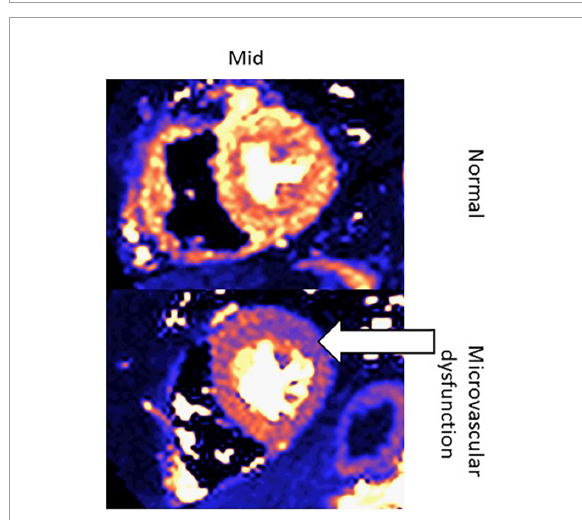
FIGURE13 Quantitative perfusion CMR assessment of myocardial microcirculatory damage in a normal patient vs. cancer patient undergoing cardiotoxic chemotherapy. These are two left ventricular short-axis images of the mid-segment myocardium. The top row contains an image from a healthy patient, whereas the bottom row contains an image from a patient with microvascular dysfunction due to chemotherapy. The white arrow indicates the area of the left ventricle with the greatest microvascular